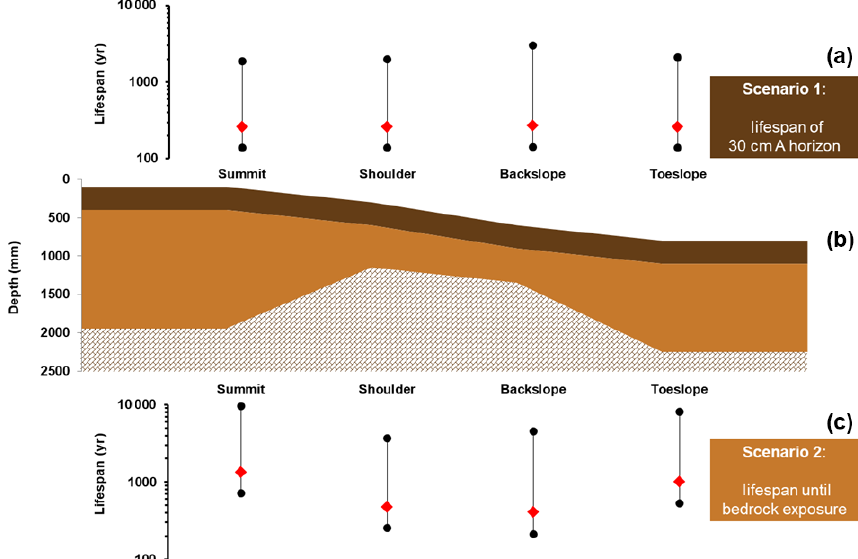
Figure 5. First-order soil lifespans calculated at four catena positions at Rufford Forest Farm for Scenario 1 (the time until the erosion of a 30cm A horizon) and Scenario 2 (the time until bedrock exposure). Panel (b) indicates the thickness of the A horizon (dark brown), the subsoil (light brown) and the depth to the soil–saprolite interface (bricks). Red diamonds denote lifespans calculated using a mean annual soil erosion rate of 1.19mmyr − 1 from Quine and Walling (1991) and soil formation rates from this study. Black dots denote the minimum and maximum lifespans calculated using the 5th and 95th percentile of the soil erosion dataset and the 1 σ uncertainties in the soil formation